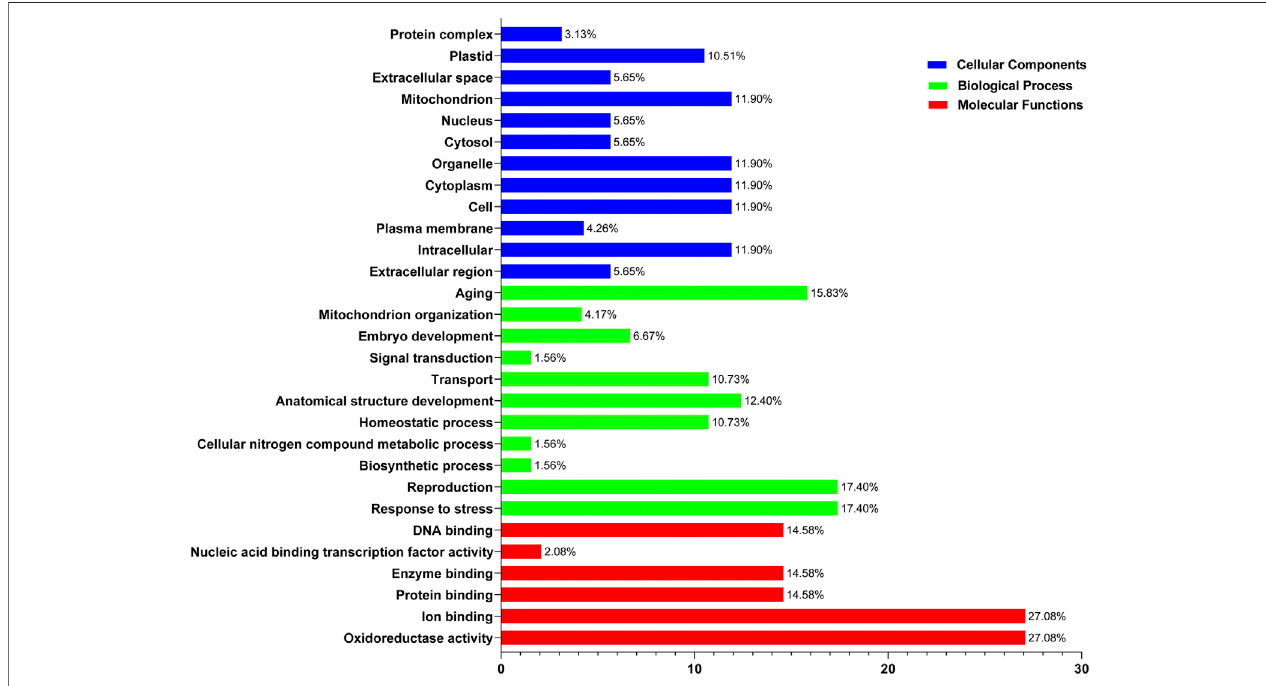
FIGURE8| GeneOntology(GO)annotationresultsofSODgenesof fi vespeciesintheCucurbitaceaefamily.GOanalysisofSODproteinsequencesisanalyzedfor their involvement or function in three important categories: biological process, molecular function, and cellular component.